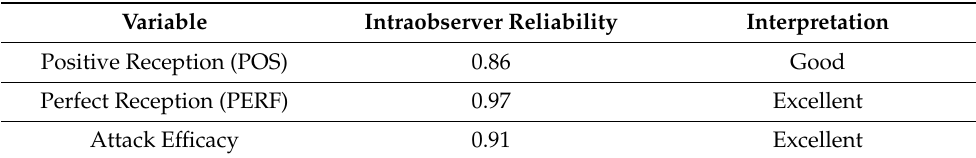
Table 2. Intraobserver reliability (Intraclass correlation